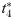
The different detectors for the constructed δ-syllable and for lny64’s song at t4*.Point centres show latency; error bars show jitter.